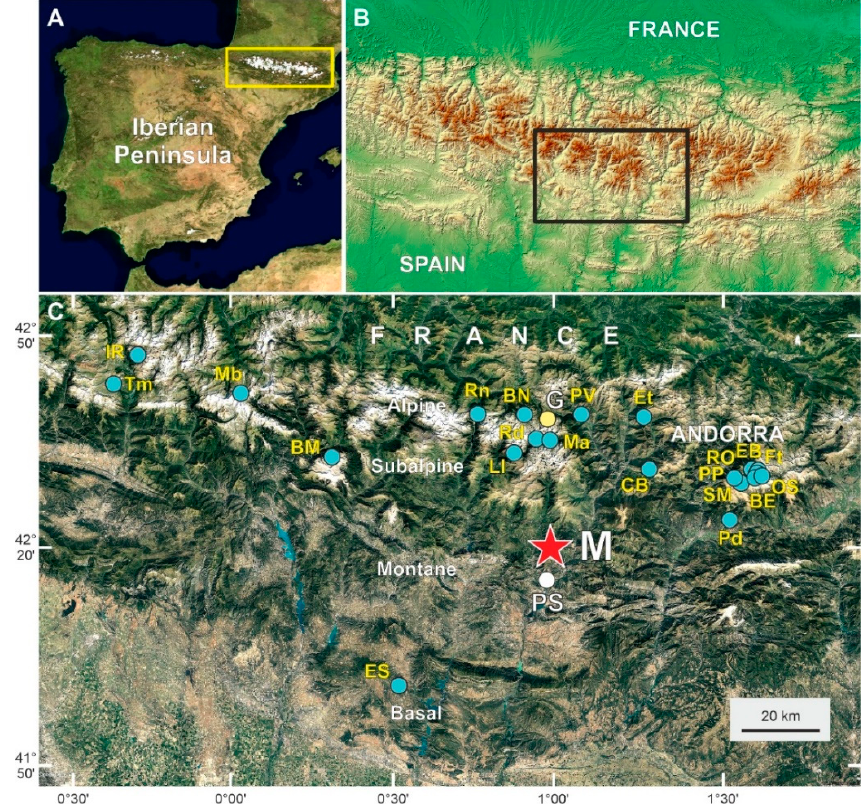
Figure 1. Location map. ( A ) The Iberian Peninsula and the Pyrenees (yellow box). ( B ) Closer view of the Pyrenees with the central Iberian side highlighted by a black box. ( C ) Google Earth close-up of the central Iberian Pyrenees showing the location of the sites with palynological studies (blue dots). Lake Montcortès (M) is represented by a red star, and Lake Gerber (G) is shown by a yellow dot. The weather station of La Pobla de Segur (PS) is represented as a white dot. The locality codes correspond to the abbreviations in Table 1. Modified from [32].